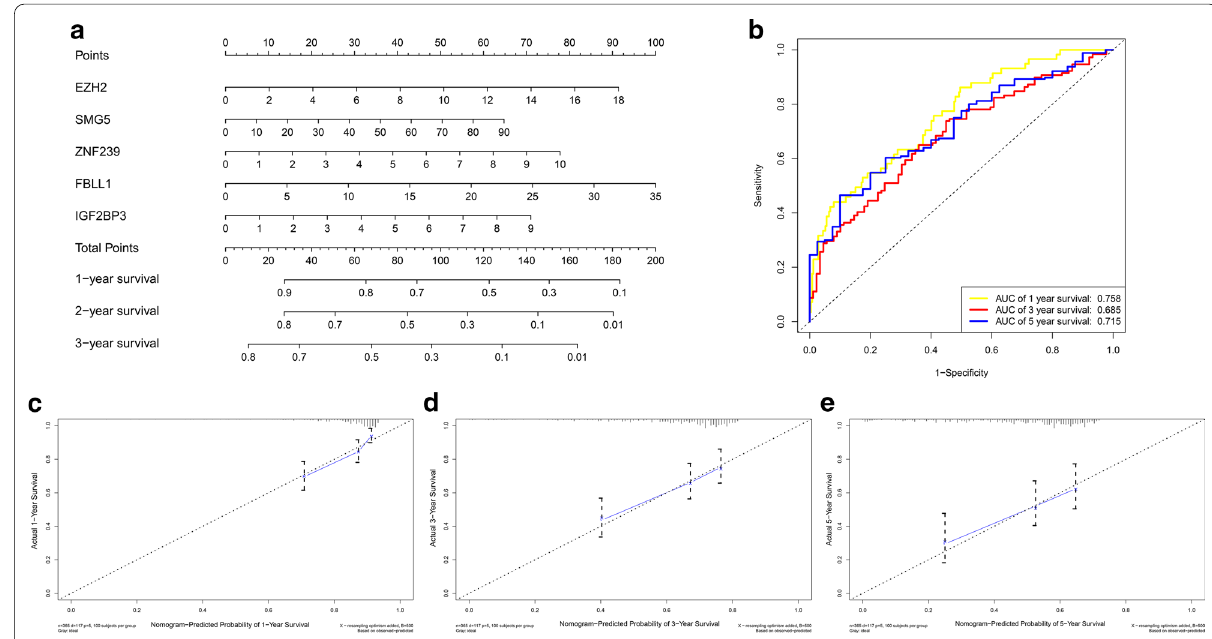
Fig. 7 The RBPs nomogram for prediction on survival probability in HCC patients. a Development of nomogram for predicting 1-, 3-, and 5-years OS for HCC patients. b 1-year,3-year, and 5-year survival ROC of nomogram. c The calibration curve for predicting HCC patient 1-year survival. d The calibration curve for predicting HCC patient 3-year survival. e The calibration curve for predicting HCC patient 5-year survival. X-axis: Nomogram-predicted probability of overall survival; Y-axis: actual overall